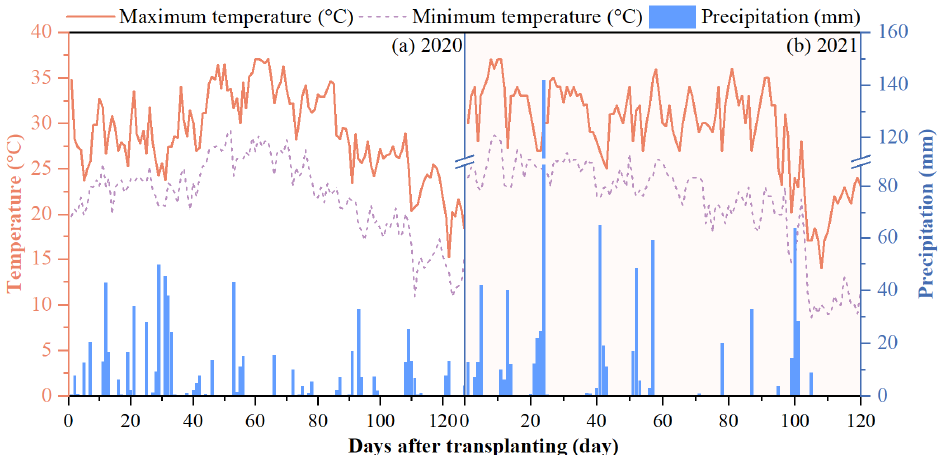
Figure 1. Dynamics of daily rainfall and air temperature during the rice-growing season in 2020 ( a ) and 2021 ( b ) at the experiment site.